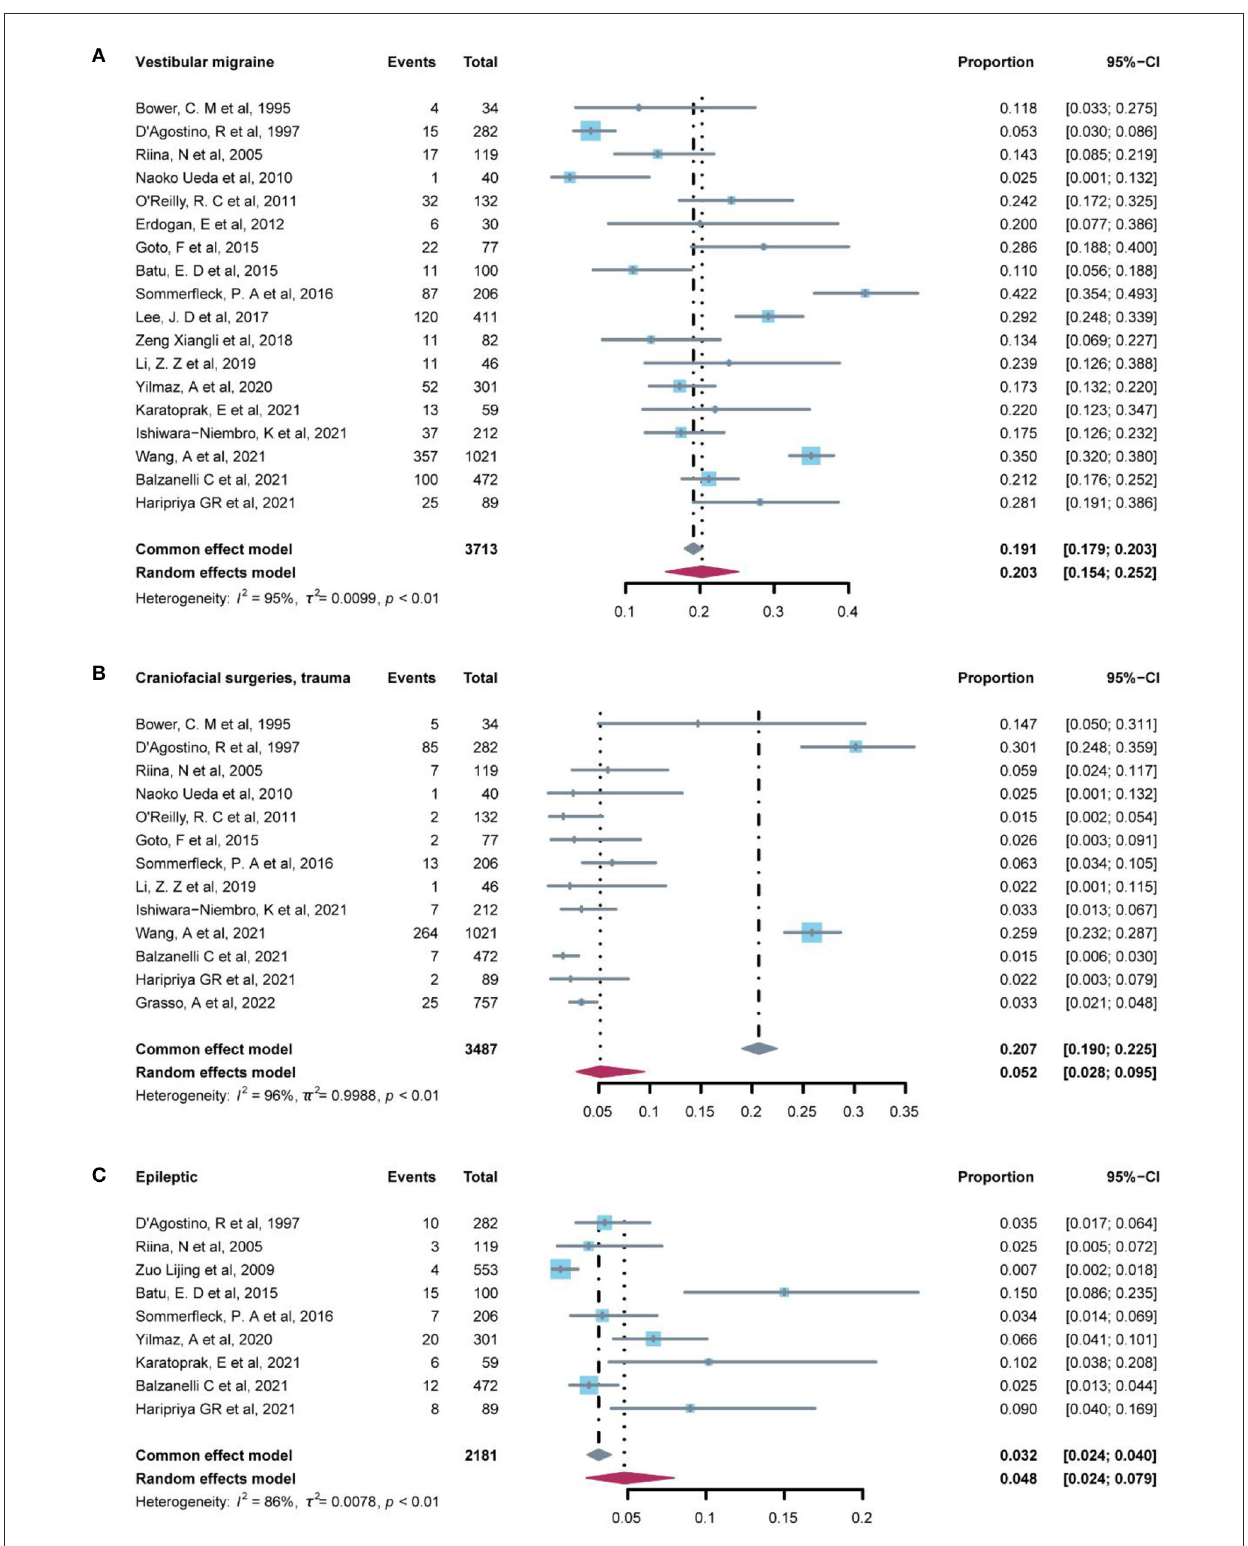
FIGURE3 Forest plot of common diagnosis in central vertigo.